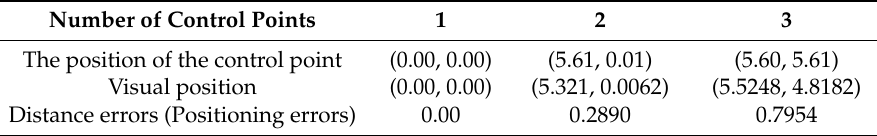
Table 2. Position comparison of visual and control points (in meters).